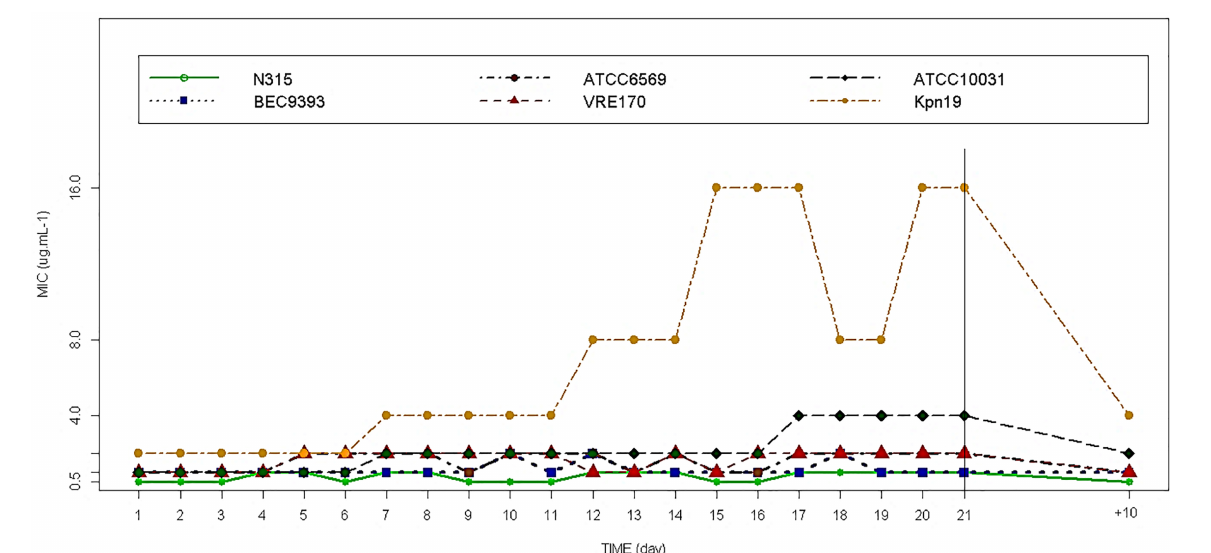
∼ 10 10 CFU from the cell suspension culture. Following 48 h, no resistant colonies were observed, and all strains tested were unable to produce resistant mutants, when plating on media with Fluopsin C (4 × MIC), giving the calculated frequency of resistance below 10 − 9 . The frequency of resistant clones cultured in 2 × MIC of Fluopsin C was determined as well. The MPC and frequencies are shown in Table 1 and Figure 2